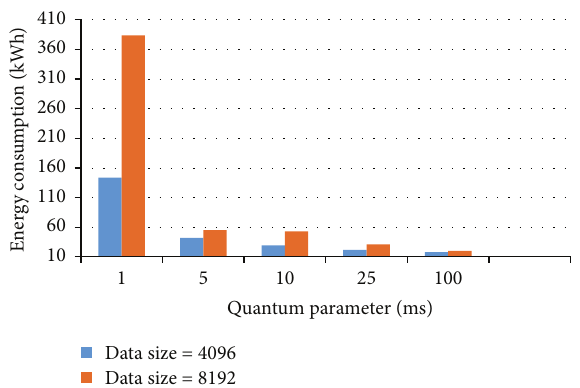
Figure 10: Energy consumption and quantum parameter with two dataset sizes.